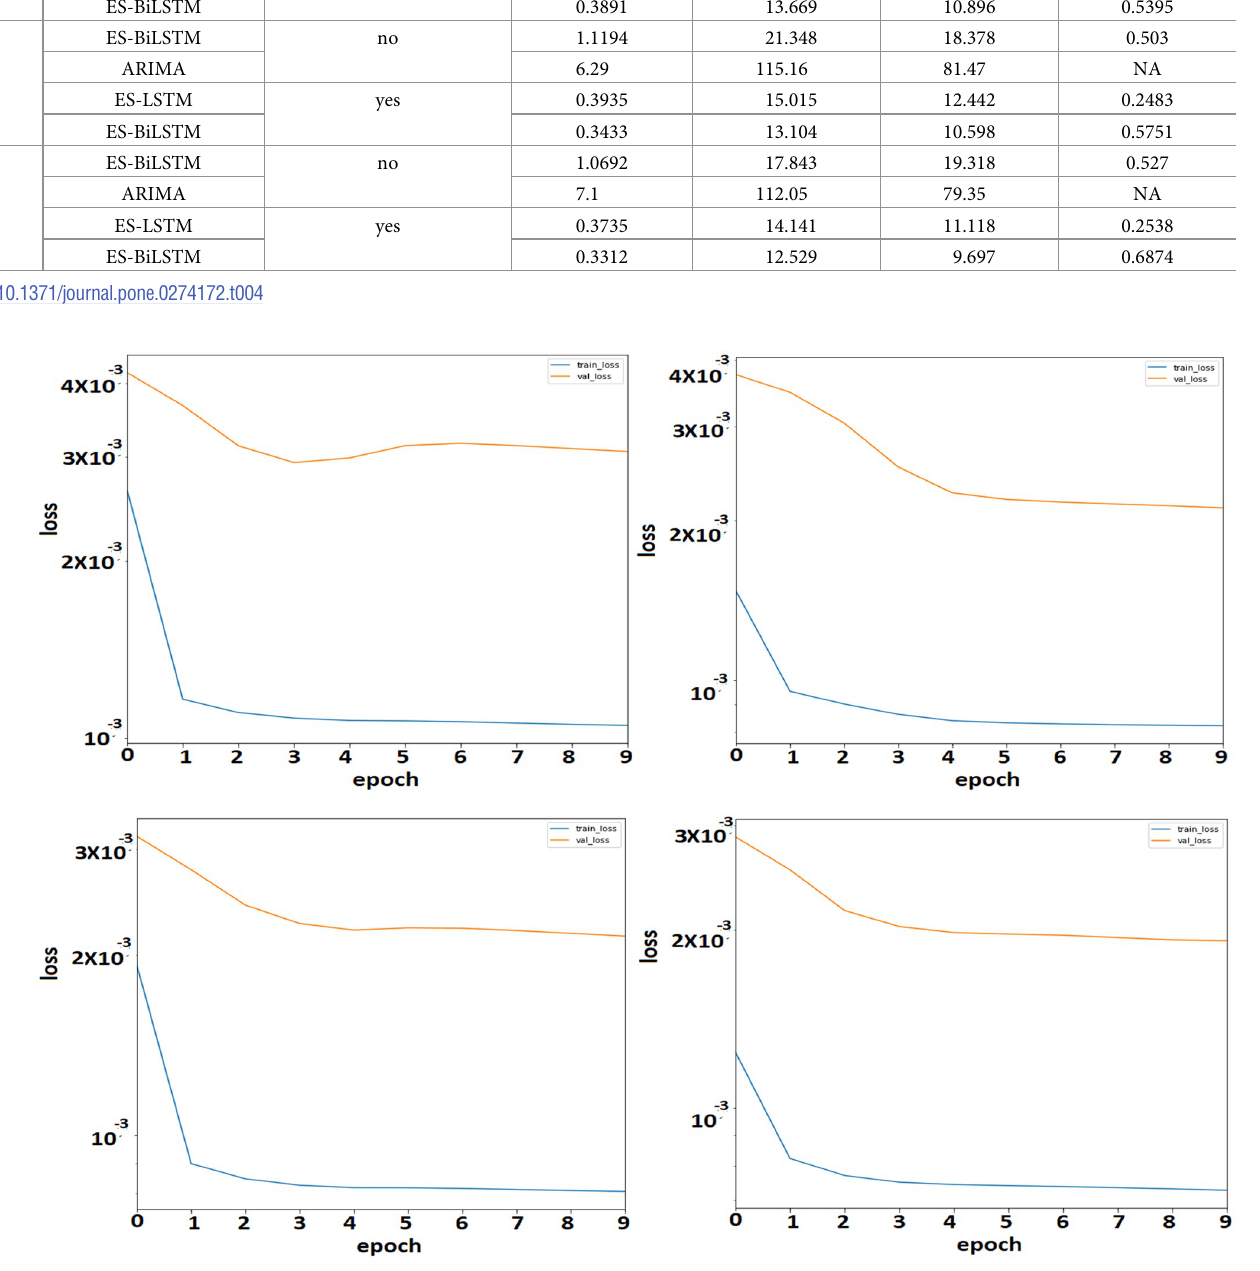
Fig 6. Hourly loss plot between training and evaluation without including the number of crime types in